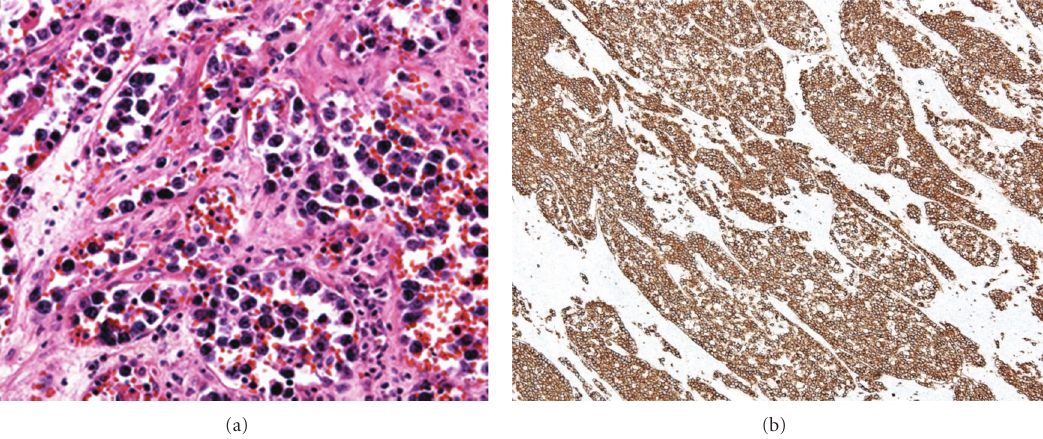
Figure 4: Histological examination of the specimen obtained by adrenalectomy. (a) Atypical lymphocytes with large nuclei were mainly infiltrating into the lumina of small vessels. (b) Infiltrating cells were positive for